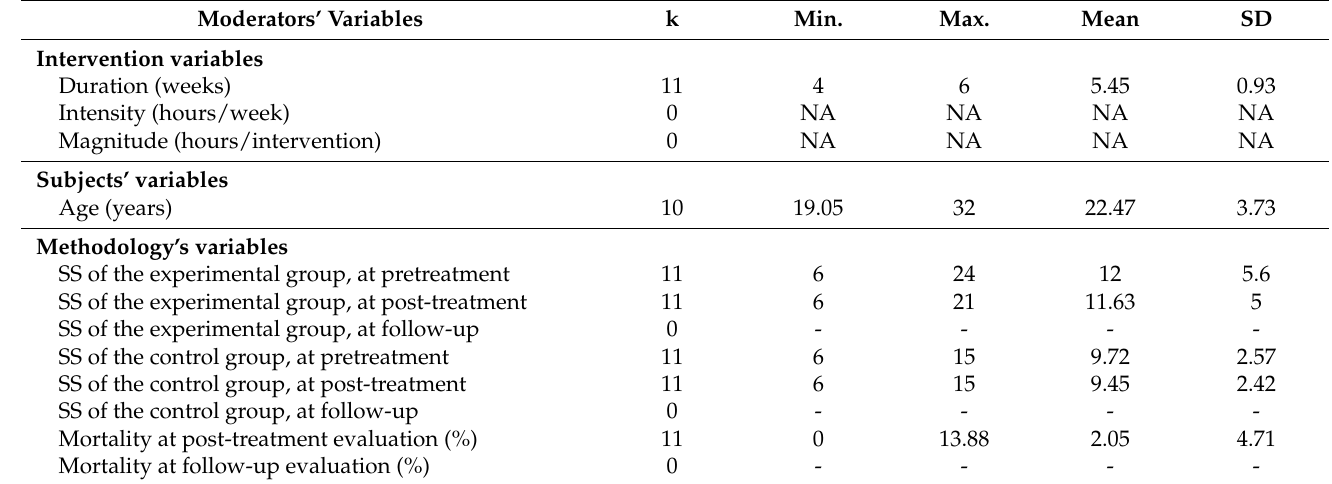
Table 6. Characteristics of the sample and the intervention of selected articles and their quantita- tive